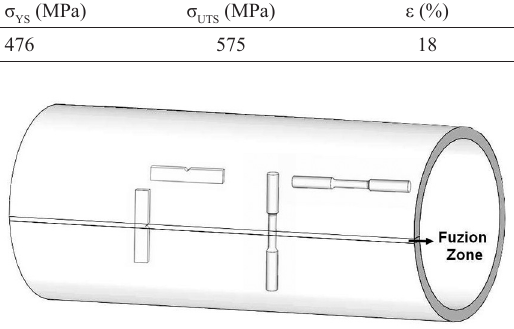
Table 2: Mechanical properties of API 5L X65 analyzed steel.